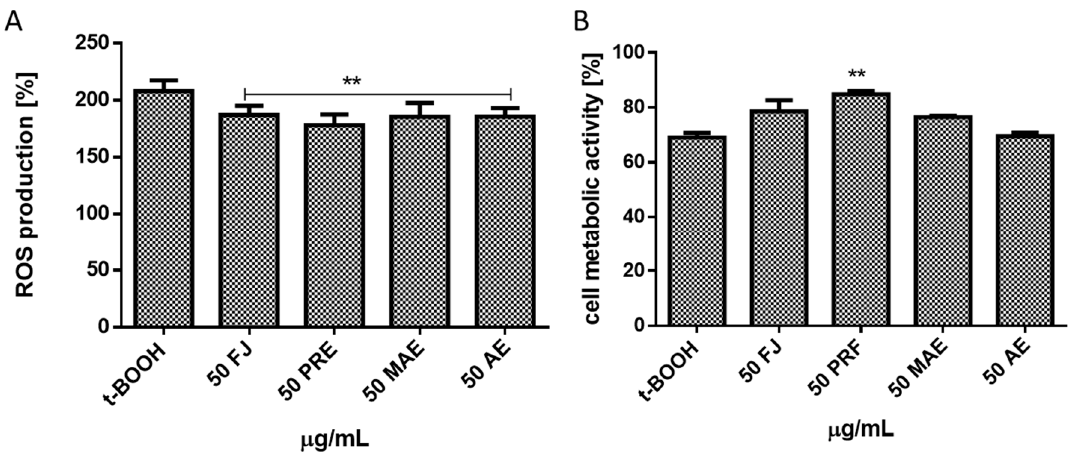
Figure 4. The cytoprotective properties of V. opulus extracts (FJ—fresh juice, PRF—phenolic rich fraction, MAE—methanol-acetone extract, AE—acetone extract) at 50 µ g / mL dosage (24 h preincubation)